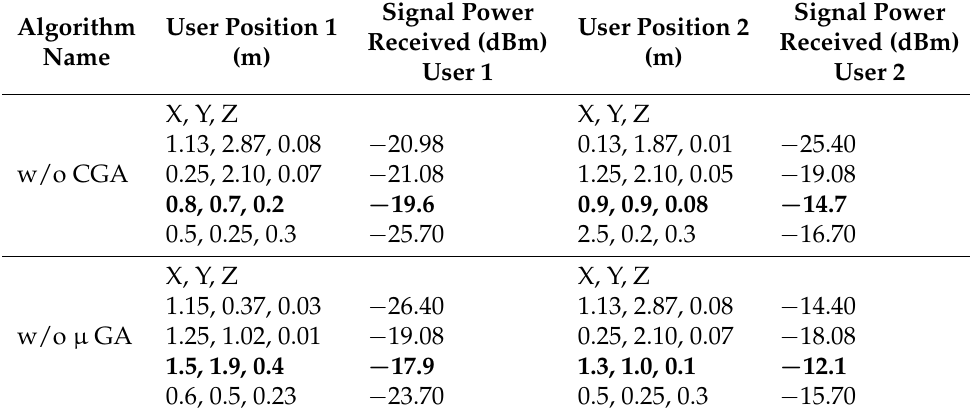
Table 11. Verification of the achieved final coordinates without using the optimization